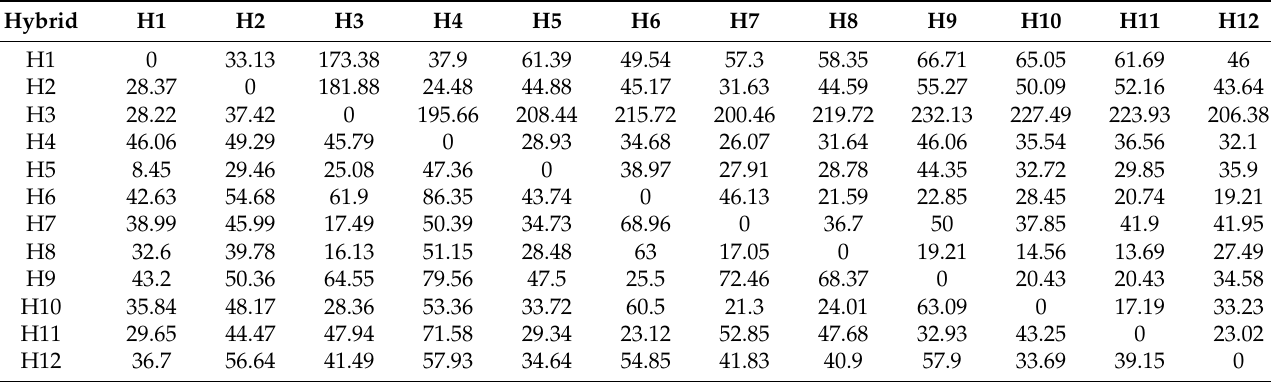
Table 6. The Mahalanobis distances between the studied hybrids in vegetative stage (above diagonal) and flowering stage (below diagonal) (N =